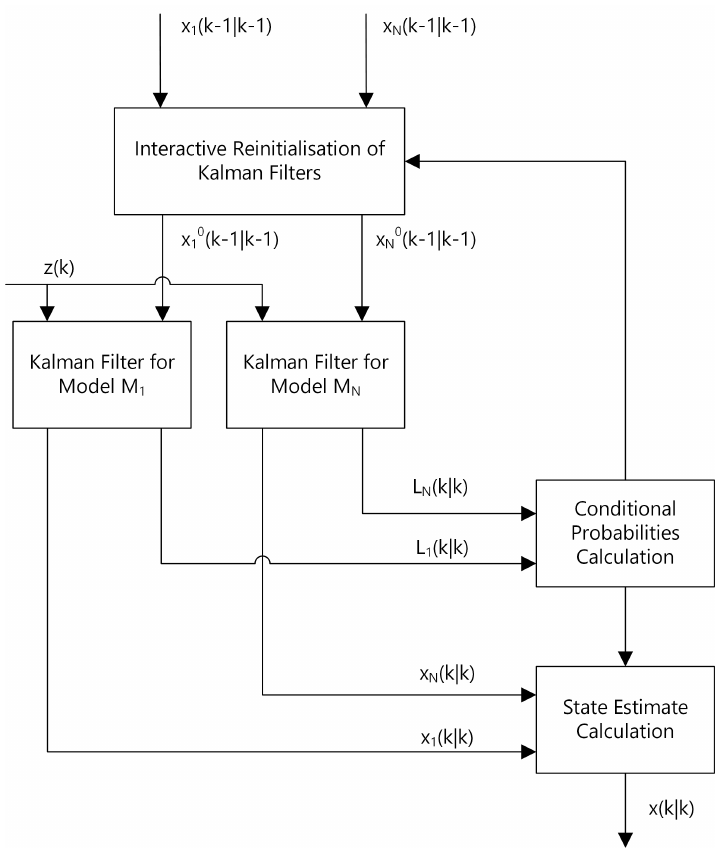
Figure 4. Interacting Multiple Model (IMM) algorithm block diagram